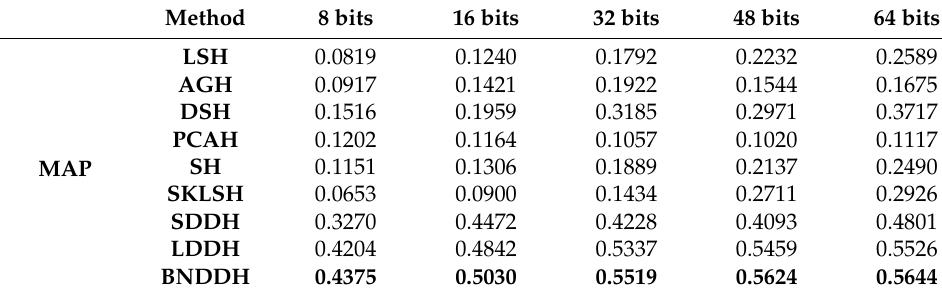
Figure 6. Precision and recall on the CIFAR-10 database ( a ) precision ( b ) recall. Table 2. MAP of different hash code lengths on the CIFAR-10 database.